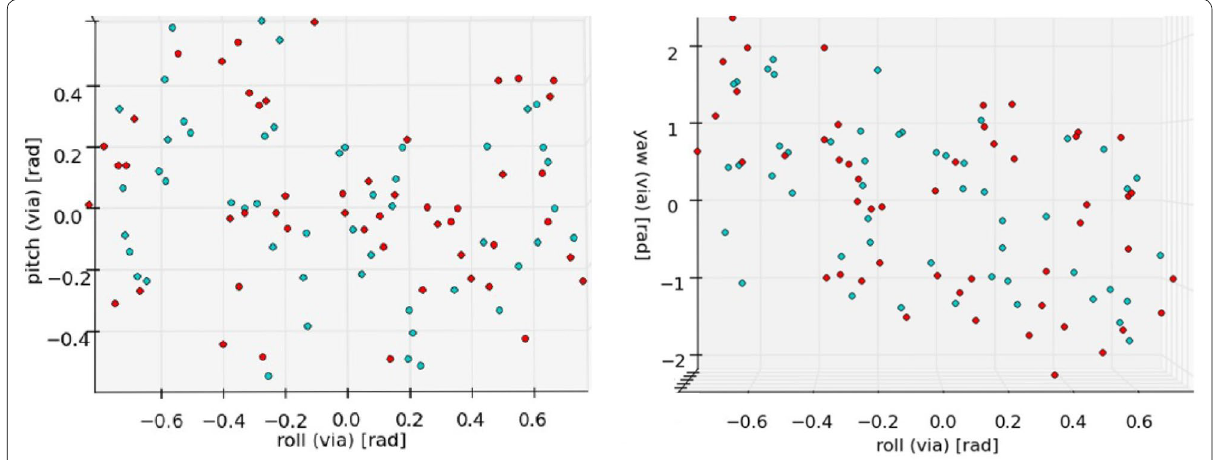
Fig. 12 Tendency of success/failure to the difference of angle